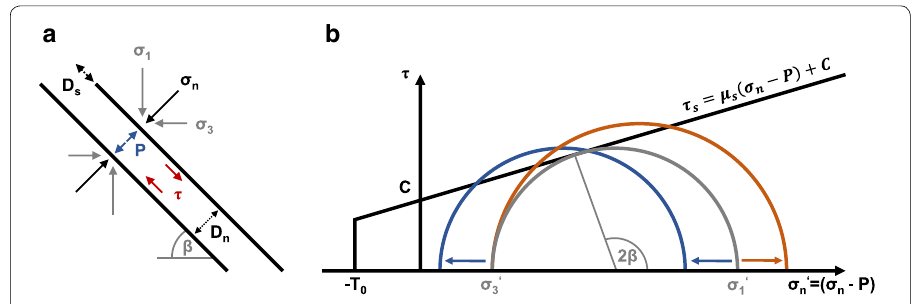
Fig. 1 Mohr–Coulomb strength criterion: a driving stress (shear stress τ ) and clamping stress